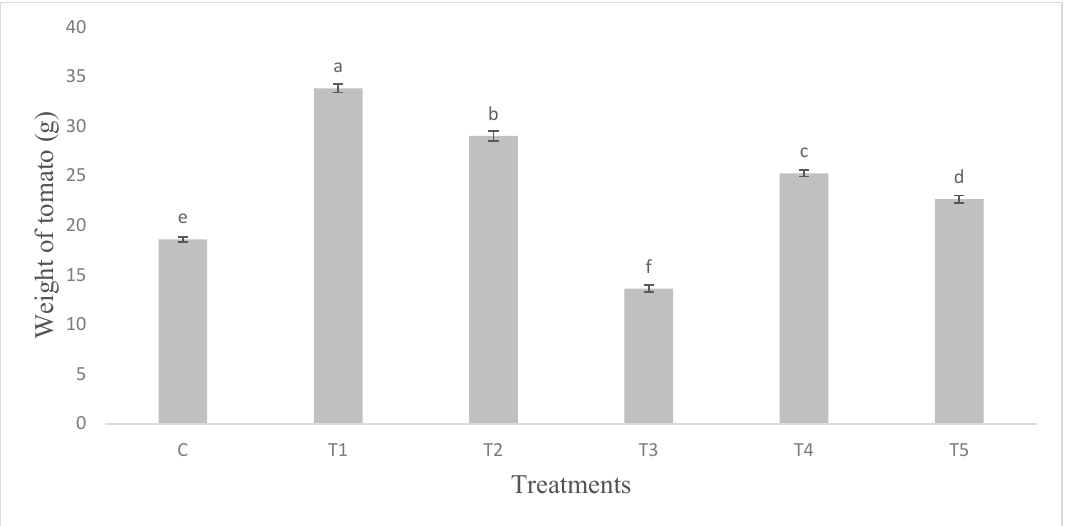
Figure 8. Weight of tomato fruits/plant (g) infested with S. litura and under control condition. Data are means of four replicates along with standard error bars. Different letters are indicating significant differences ( p < 0.05) among treatments.